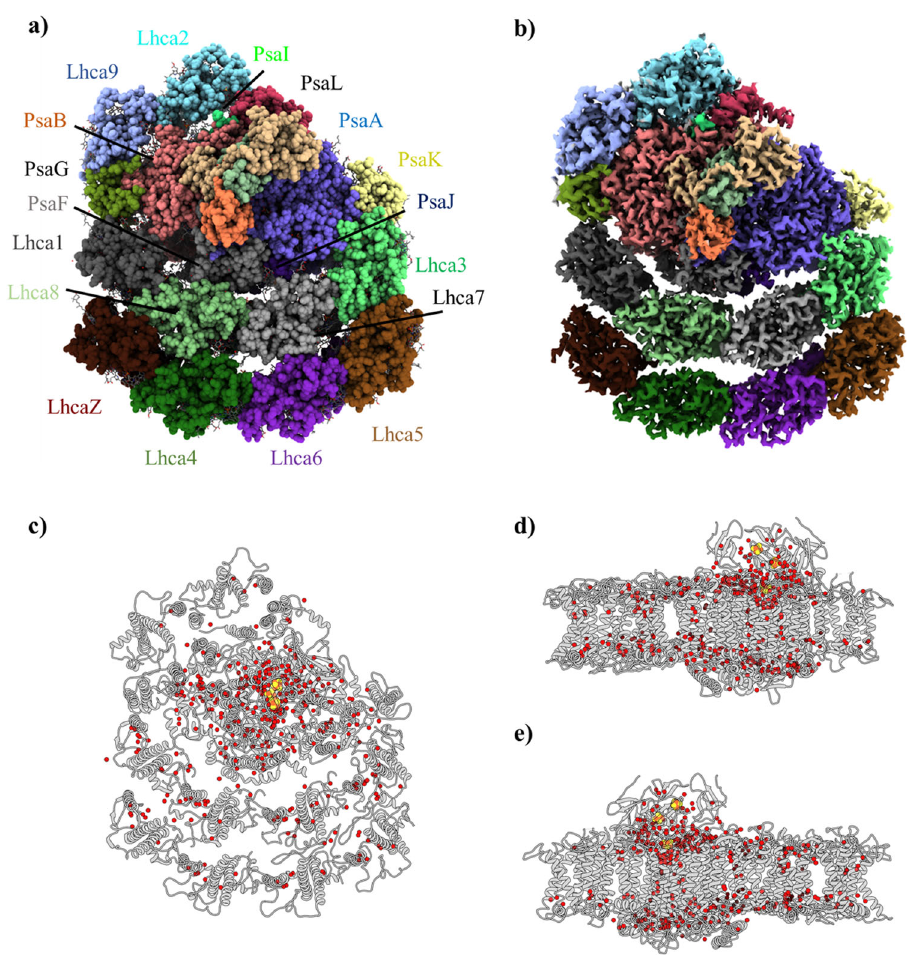
Fig. 2 Structure of C. reinhardtii TSP4 – 10LHC PSI at 2.54 Å and the distribution of water molecules within the complex. a TSP4 – 10LHC 2.54 Å PSI model. The subunits are annotated according to their corresponding colours. The stromal subunits (PsaC, PsaD and PsaE) are shown but are not annotated for clarity. b Cryo-EM 2.54 Å map of TSP4 – 10LHC, coloured according to the subunits in panel a . Stromal ( c ) and the membrane plane view ( d ) – from the PsaK pole; e – from the PsaG pole of the TSP4 – 10LHC water molecules. The water molecules are shown as red spheres, the iron-sulphur clusters as red- brown spheres, and PSI displayed as grey